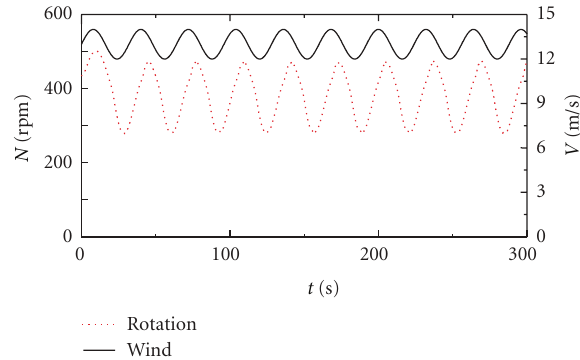
Figure 18: Time profile of the rotational speed of pulsating wind in the case where V 0 = 13 m/s, T = 32s, and I = 7 kgm 2 .